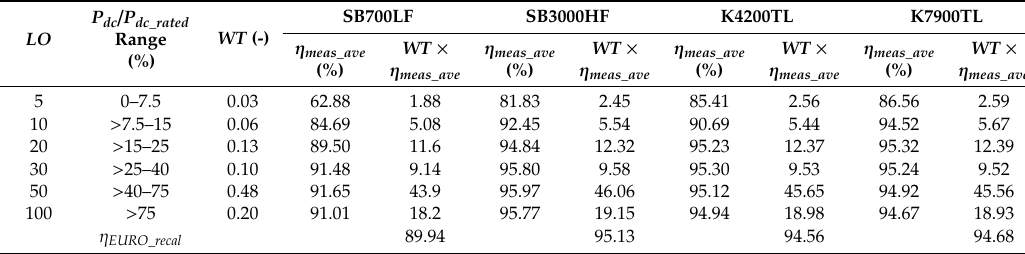
Table 3. The η EURO_recal values for the four di ff erent inverters (G = G i and T m = 25 ◦ C).